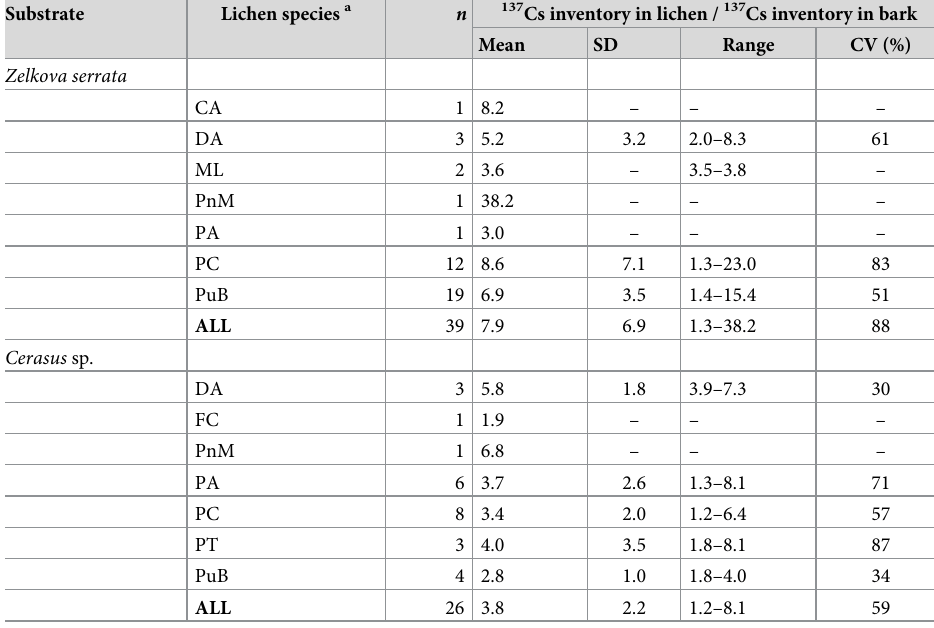
a CA, Canoparmelia aptata ; DA, Dirinaria applanata ; FC, Flavoparmelia caperata ; ML, Myelochroa leucotyliza ;